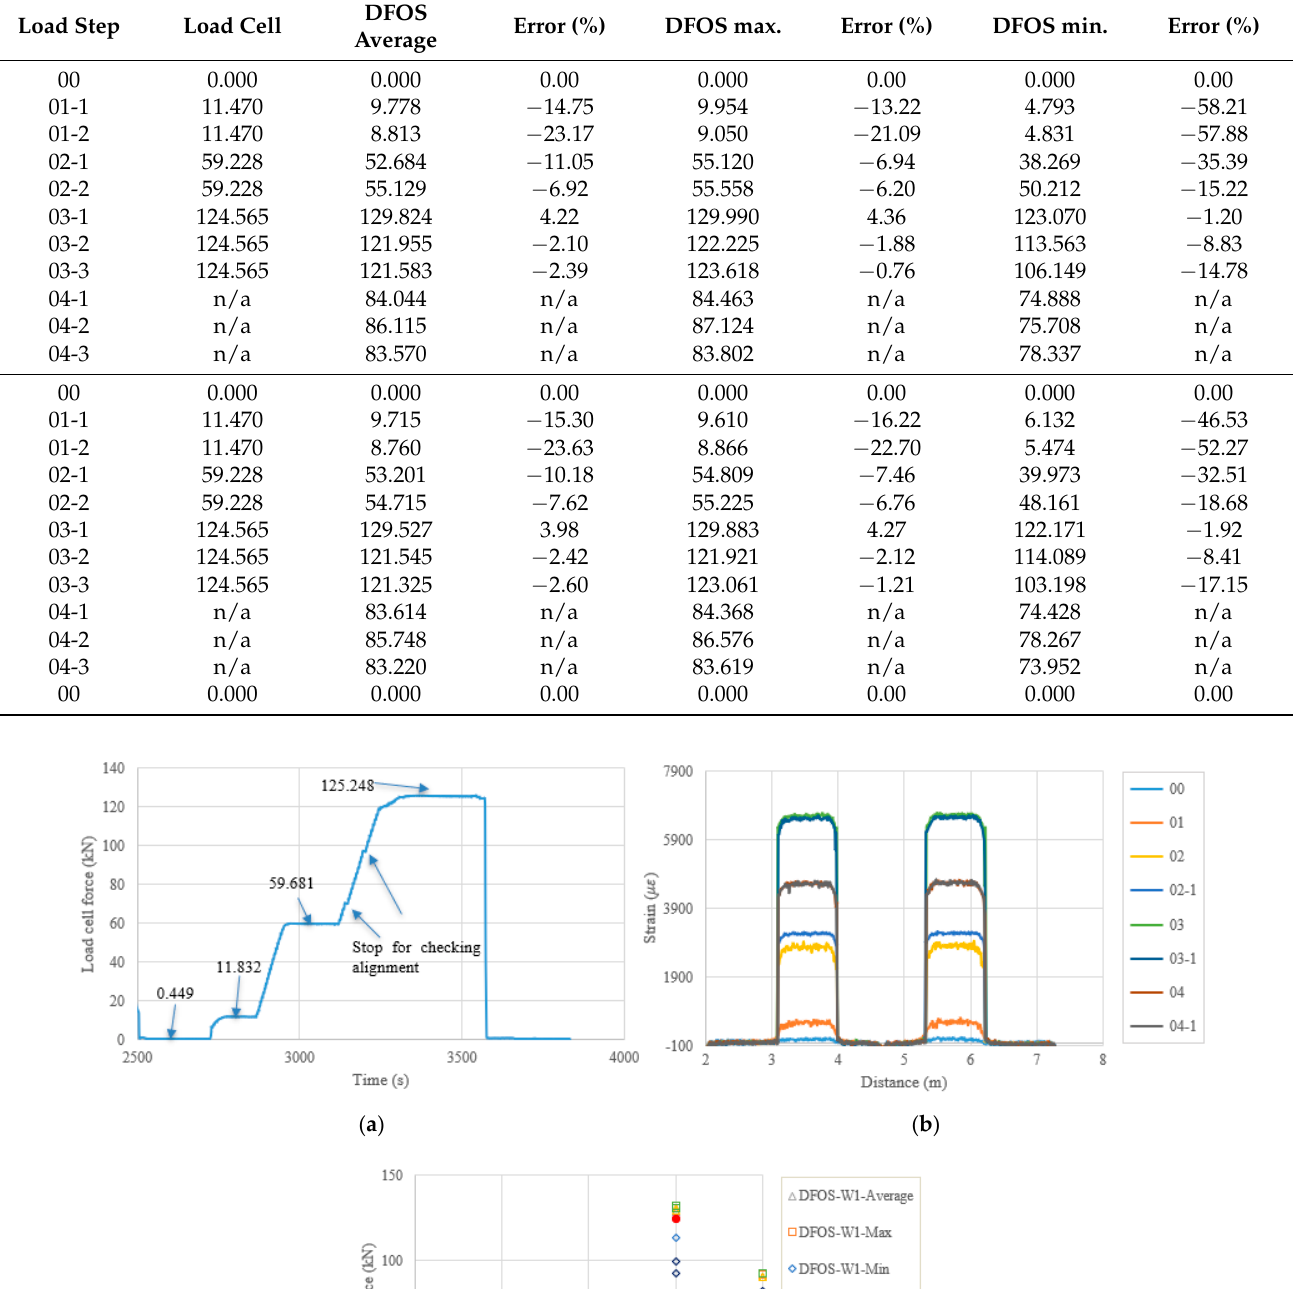
Table 6. Prestressing force monitored by load cell and DFOSs for PC6 (unit: kN).